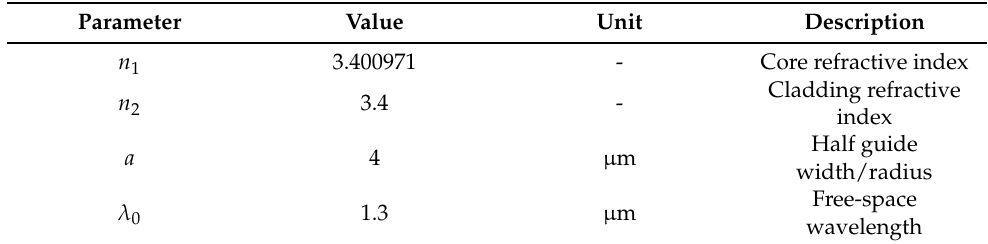
Table 1. Waveguide parameters used in the solution of the Helmholtz